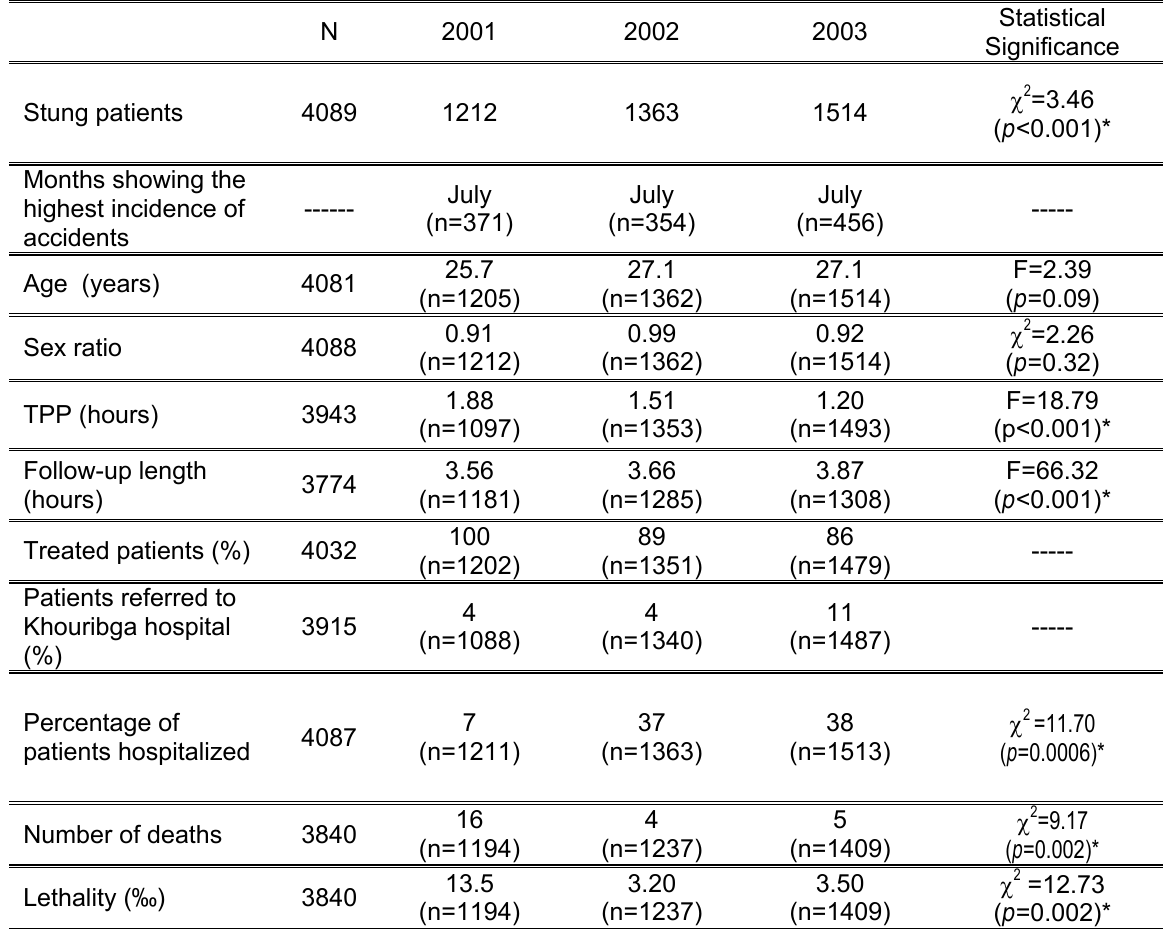
N 2001 2002 2003